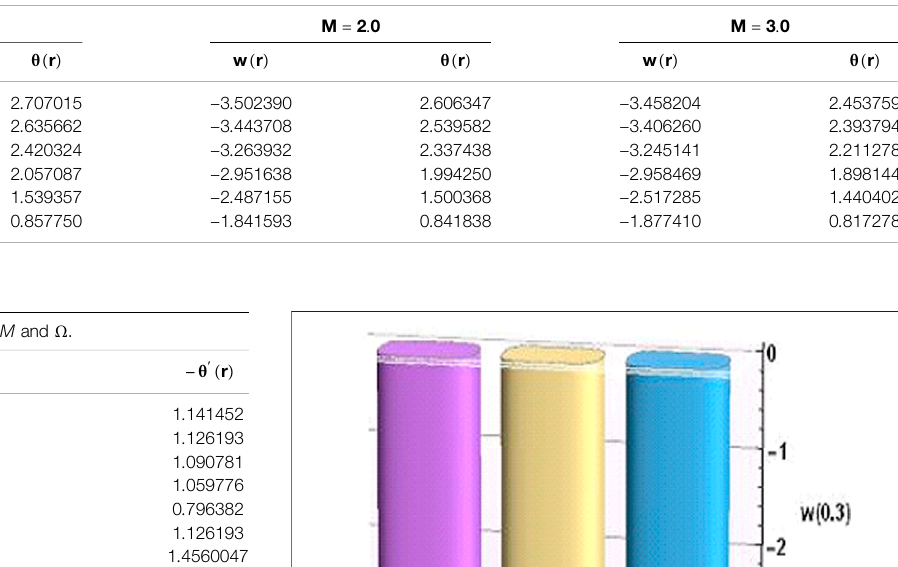
TABLE 3 | Numerical outcomes of velocity and temperature Vs. r against the magnetic parameter.